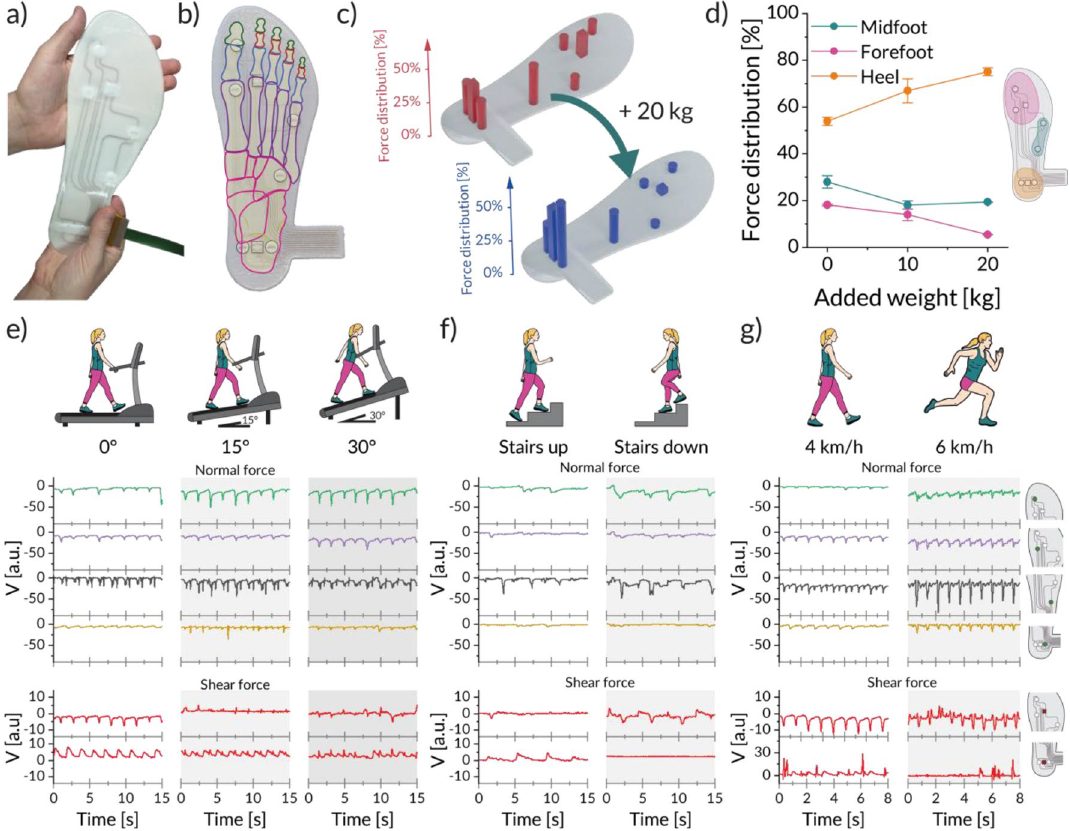
Figure 4. Fully 3D printed insole with embedded sensors and its response for various types of physical activities. ( a ) Photograph of the full insole. ( b ) Overlay of the skeletal structure of a foot over the sensor layout. Squares indicate the shear sensors and circles the normal pressure sensors. ( c ) Normal plantar pressures and shear forces sensed with the embedded sensors over the entire foot for the test subject, without any extra load and with 20 kg of added weight. ( d ) Weight distribution within the insole with increasing added load. ( e – g ) Sensor signals and their changes for several activities including ( e ) walking on inclines at 2 km/h, ( f ) walking up and down stairs, ( g ) walking at 4 km/h and jogging at 6 km/h. Illustrations in panels ( e – g ) provided by Estevam Quintino (CC BY